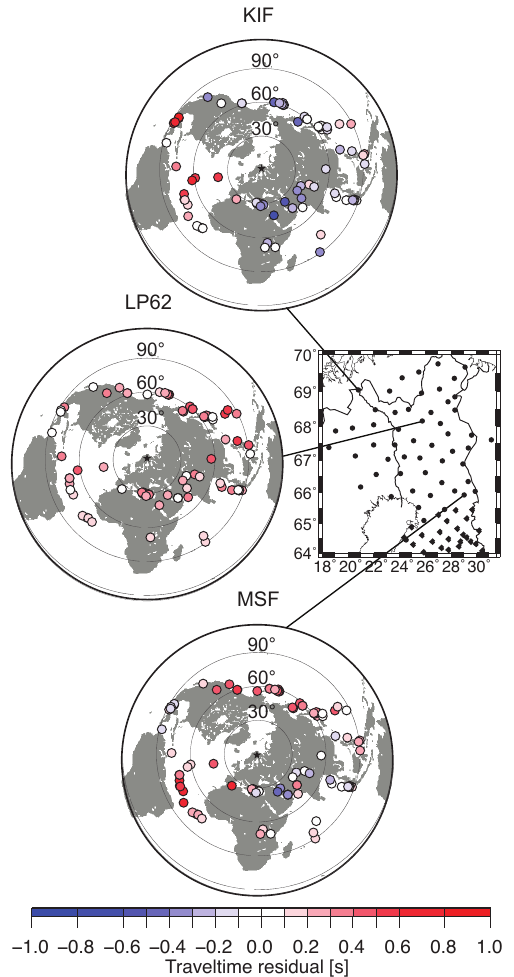
Figure 7. Distribution of crustal corrected travel time resid- uals at a few example stations from different parts of the POLENET/LAPNET